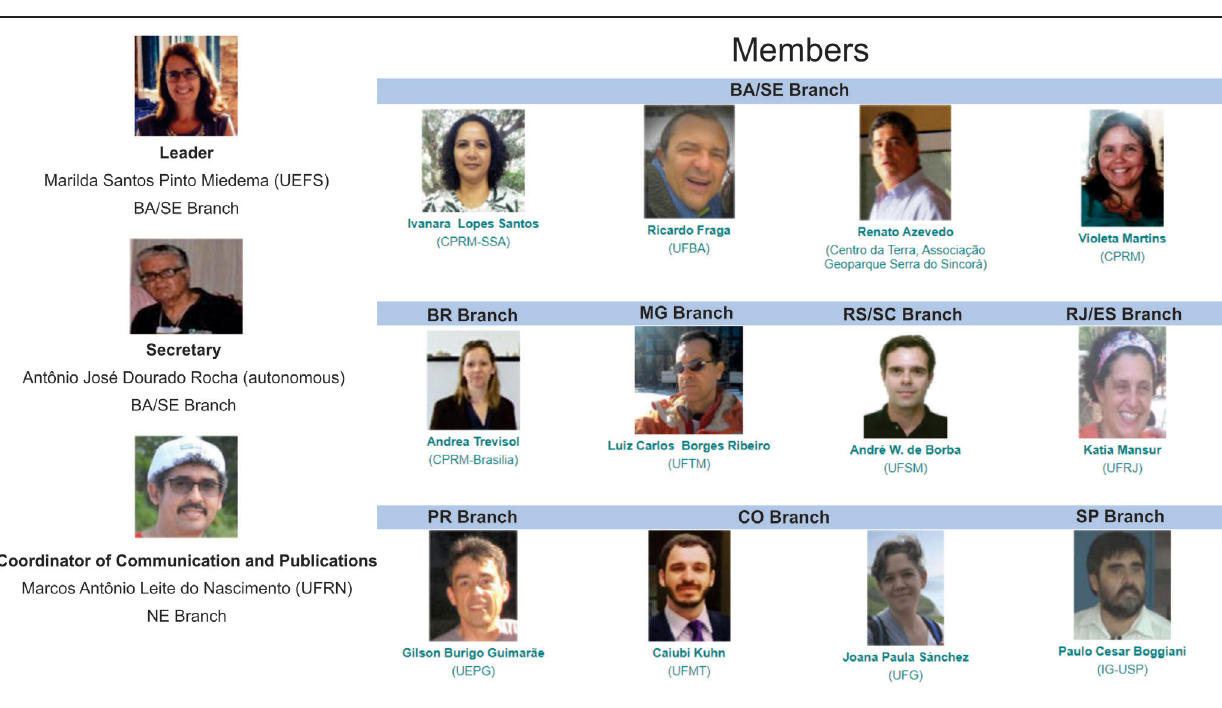
FIGURE 1. Composition of the Geoparks Commission, biennium 2020–2022 (http://www.geoparques-sbg.org.br)